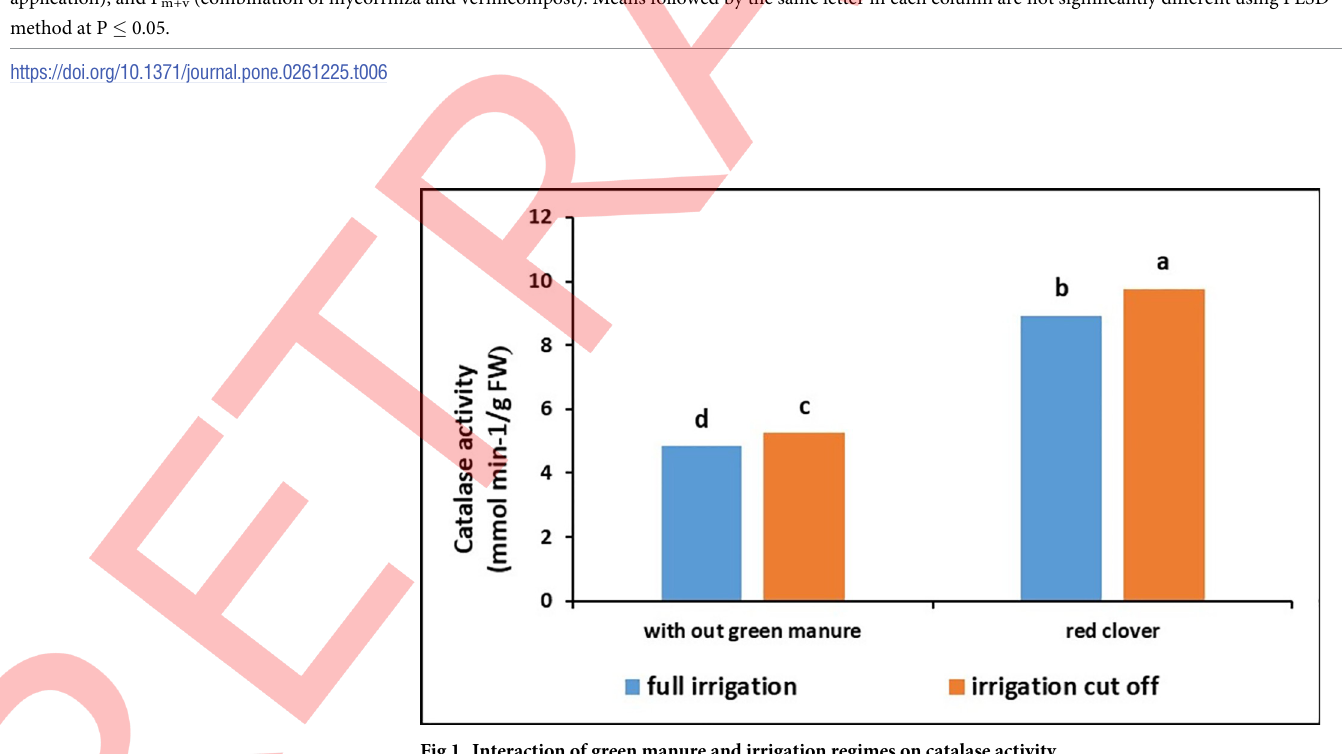
Fig 1. Interaction of green manure and irrigation regimes on catalase activity.